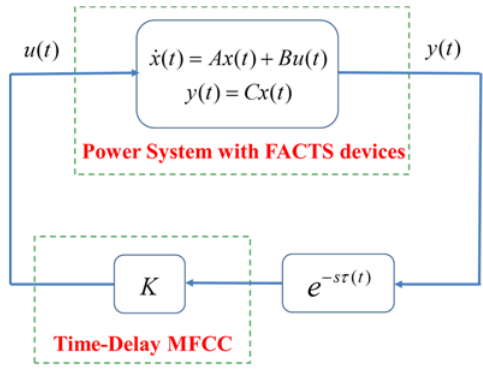
Figure 5. Closed ‐ loop time ‐ delay system under static output feedback control. Figure 5. Closed-loop time-delay system under static output feedback